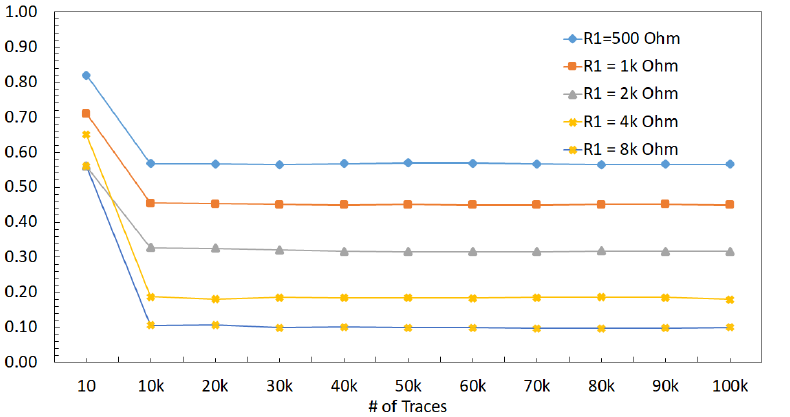
Figure 17. Correlation between V 1 and V 2 when R1 is changed from 500 Ω to 8 k Ω when the a normal sized DLDO is used as the voltage